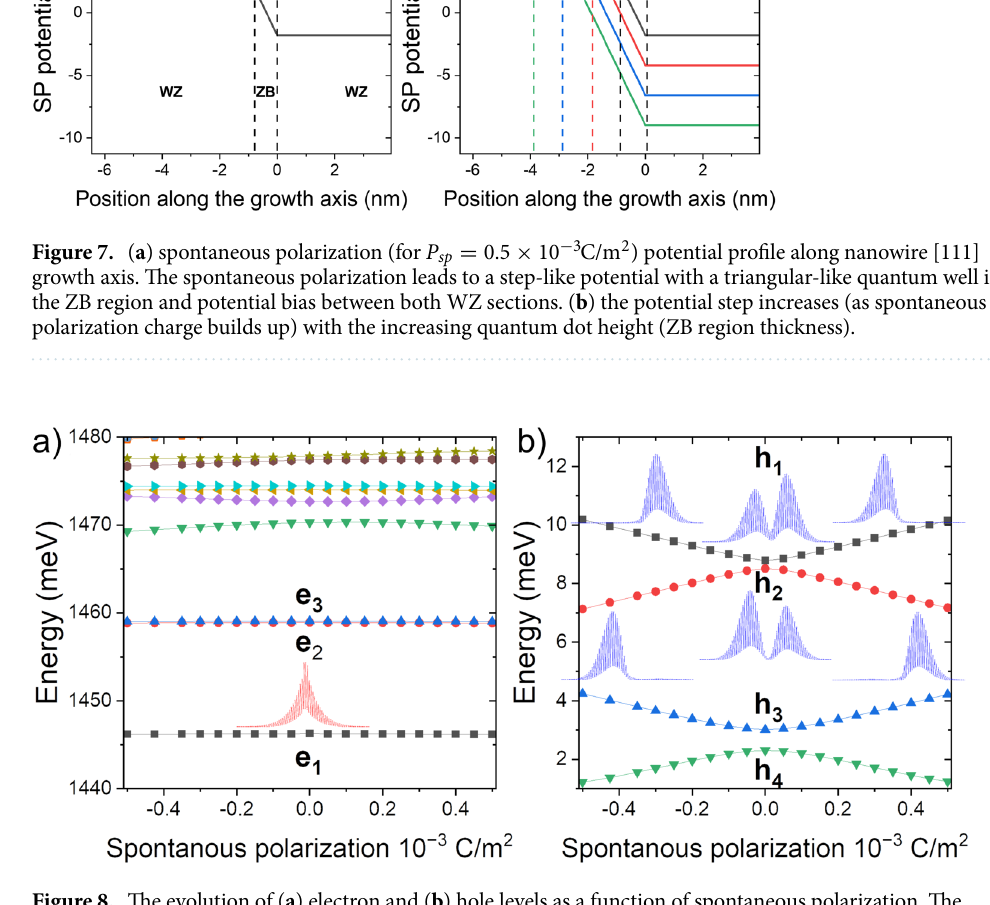
Figure 8. The evolution of ( a ) electron and ( b ) hole levels as a function of spontaneous polarization. The electron energy spectra remain rather immune to the polarization, where the field strongly splits hole states. The miniatures show corresponding charge densities for the electron ground state ( e 1 ), which virtually is not affected by the spontaneous polarization, and for h 1 / h 2 states which are strongly spatially separated by the